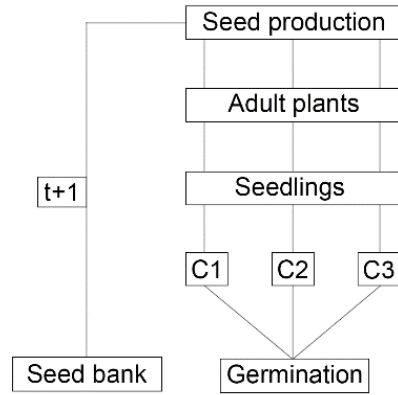
Figure 2. Life cycle of Lolium multiflorum with three cohorts (C1, C2, and C3).